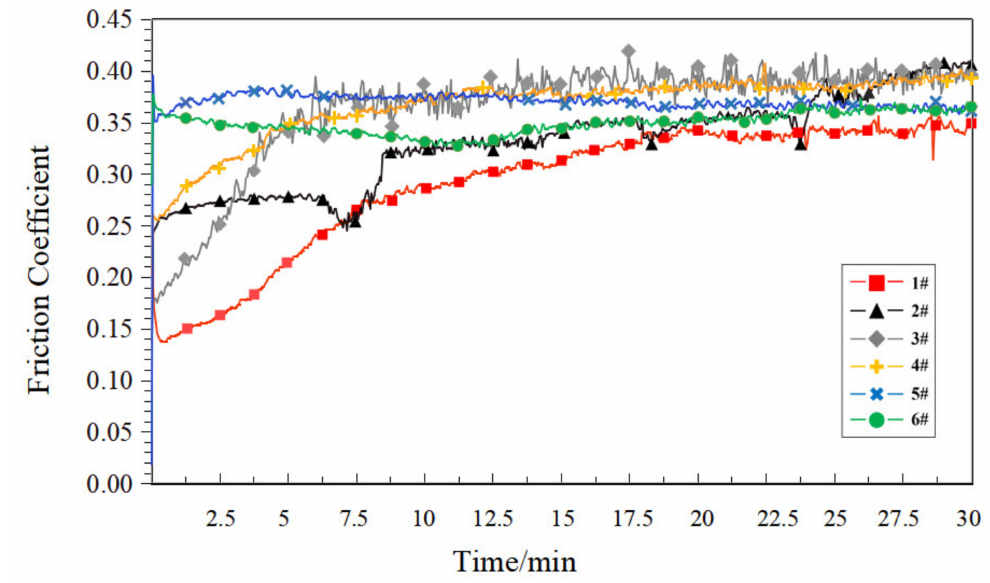
Figure 7. Friction coefficient curve of each sample under the dry friction